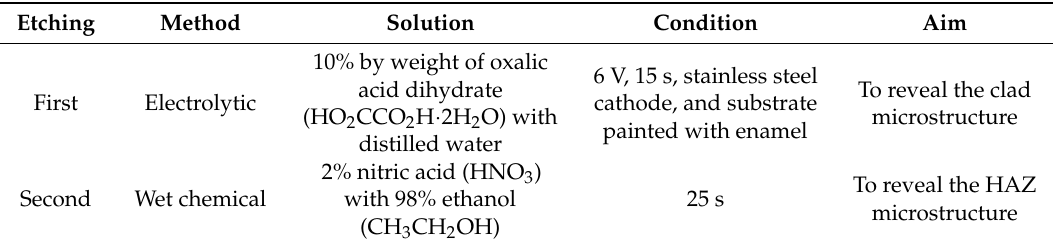
Table 4. The first and second etching methods used to reveal the microstructures of the quenched and tempered 9%Ni steel (ASTM A333 Gr. 8) pipes cladded with Ni-based superalloy 625 (AWS ER NiMoCr-3) as the filler metal by using